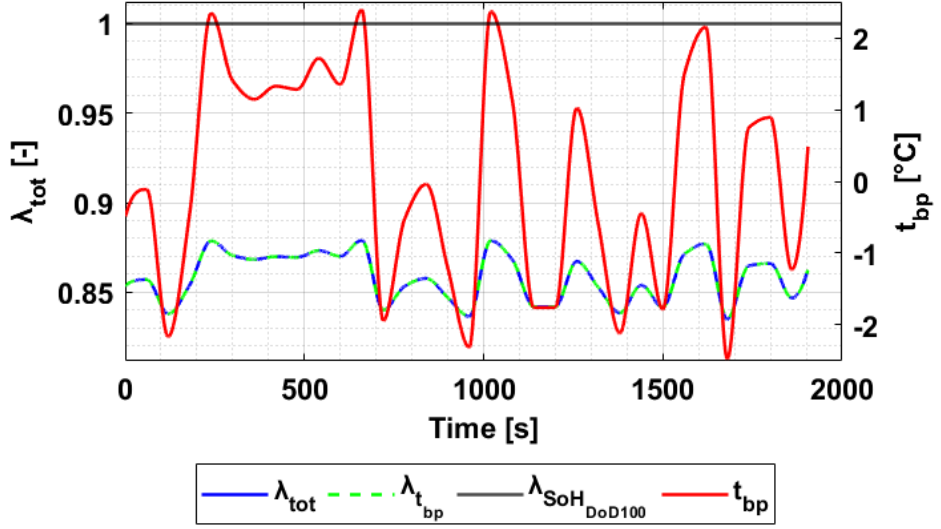
Figure 18. Combined effect of the battery pack temperature and the battery ageing level on λ tot for DM25 in the case of a new battery and DoD100.